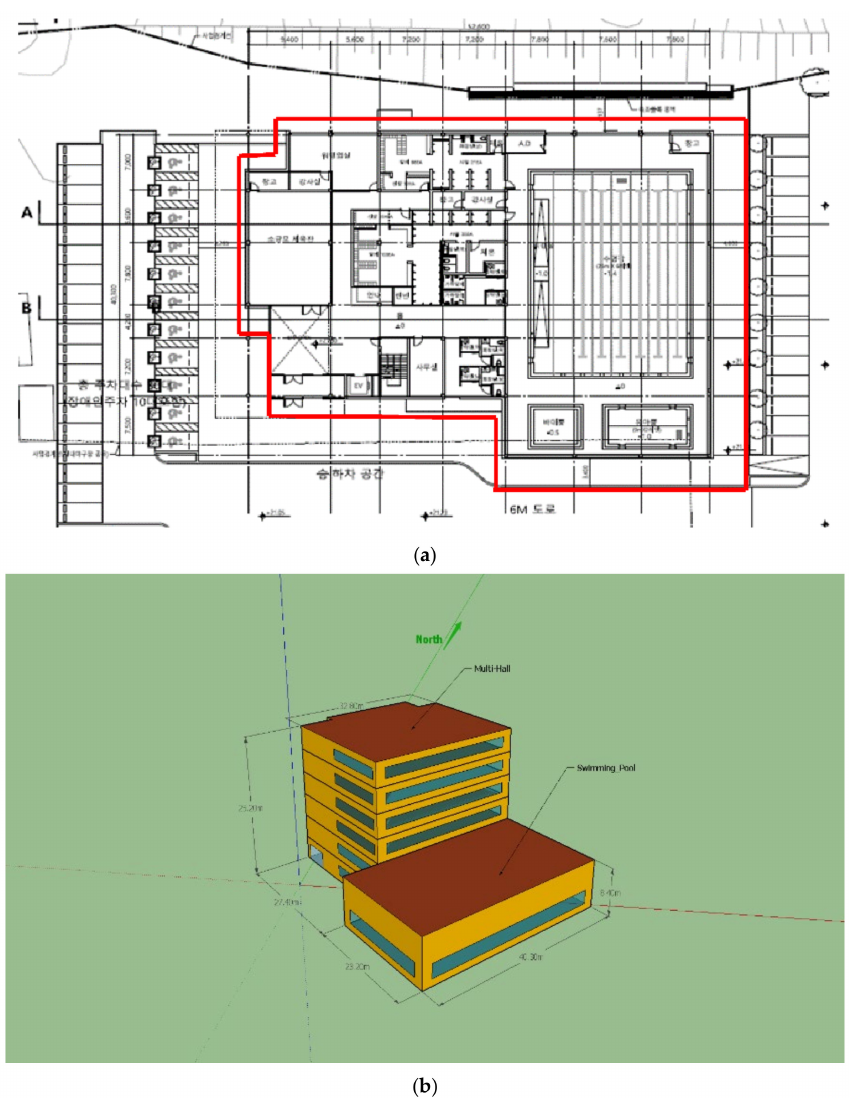
Figure 6. An architectural plan of the comprehensive sports center with an indoor swimming pool ( a ) and the 3D modeling ( b